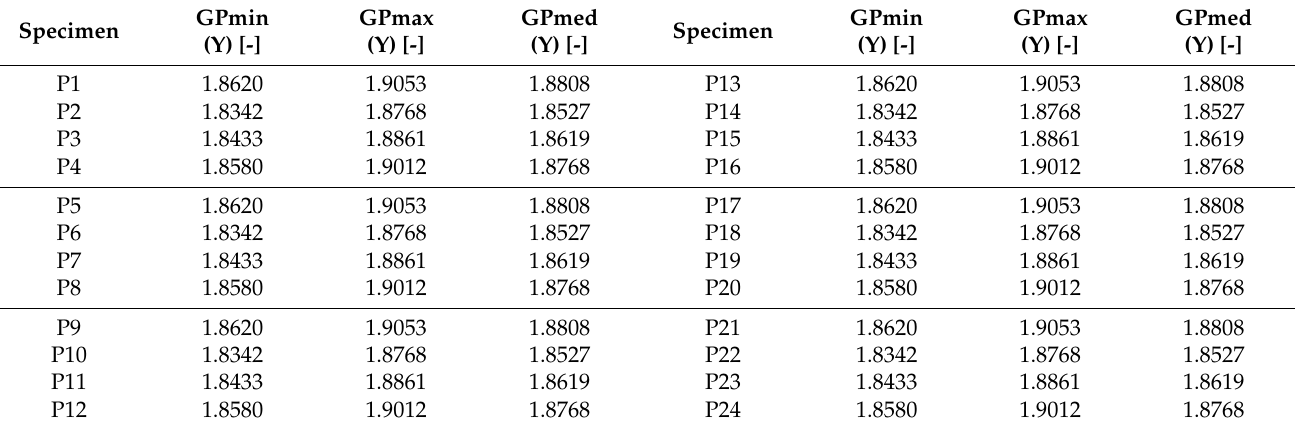
Table 3. Minimum, maximum, and medium values obtained with the complexity GP prediction